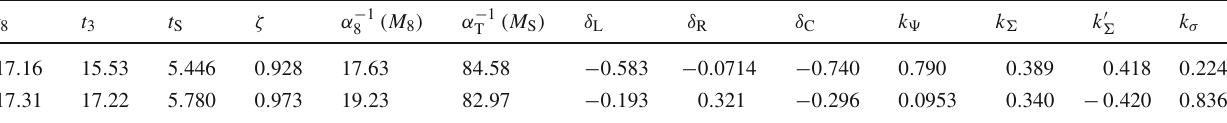
Table 8 Benchmark points used for the running of the gauge couplings in Figs. 9 and 10. The top line corresponds to a parameter space point where δ i differ considerably whereas in the bottom line their absolute values are of the same order. Here, t i = log 10 M i